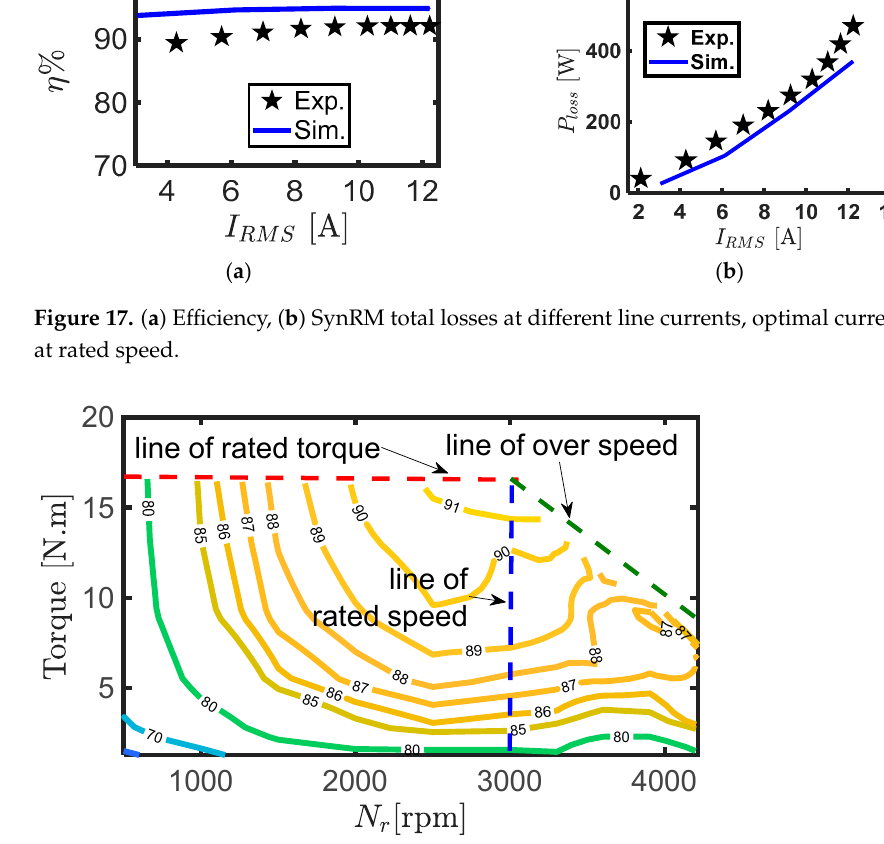
Figure 17. ( a ) Efficiency, ( b ) SynRM total losses at different line currents, optimal current angle, and at rated speed.